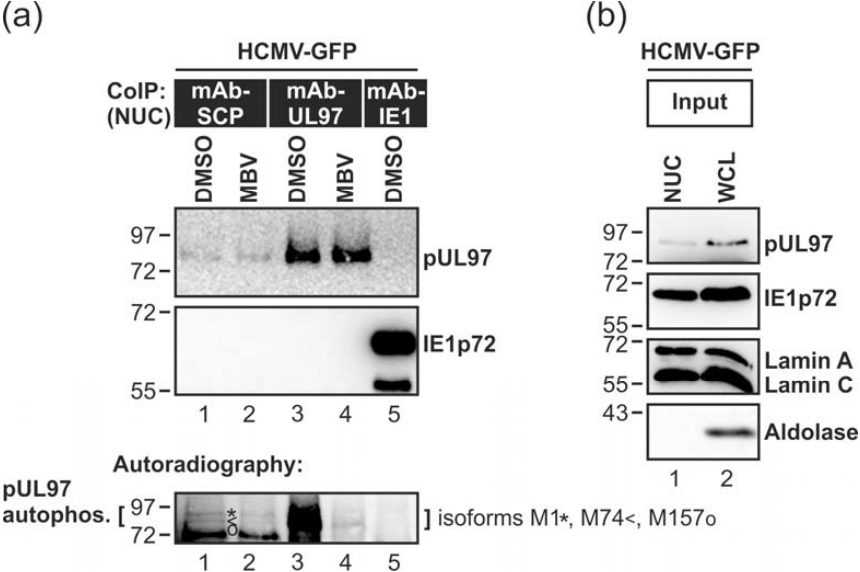
Figure 4. The kinase activity of capsid ‐ associated pUL97 purified from the nucleus of HCMV ‐ infected cells. HFFs were infected with recombinant HCMV AD169 ‐ GFP and treated with the pUL97 kinase inhibitor maribavir (MBV) or the solvent dimethylsulfoxide (DMSO). At 4 dpi, cells were harvested and the nuclear fraction (NUC) was isolated from whole cell lysates (WCL). The nuclear fraction was used for immunoprecipitation of HCMV ‐ encoded proteins SCP, pUL97, or IE1p72 as a control. Precipitates were subjected subsequently to a pUL97 ‐ specific in vitro kinase assay (IVKA). (( a ), upper panels CoIP) Prior to IVKA reactions, the quality of CoIP samples was verified by Western blot